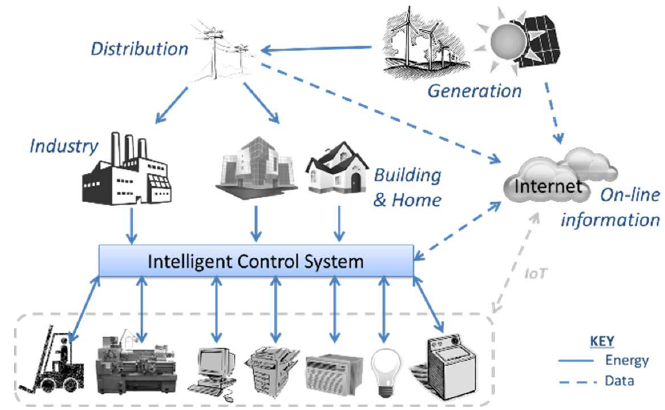
Figure 1. Structure and operation of the proposed system.